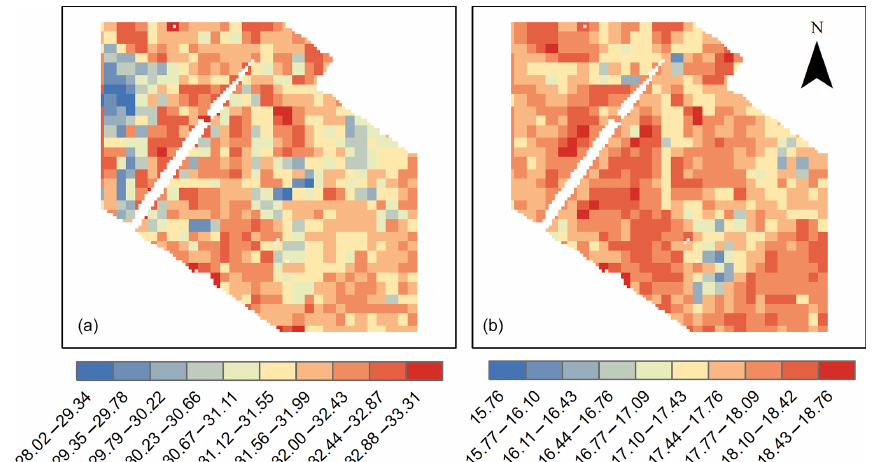
Figure 6. Spatial map of modelled T ac (30m) for (a) day (15:00) and (b) night (03:00) in the Mawson Lakes domain. Points with F roof > 0 . 75 are